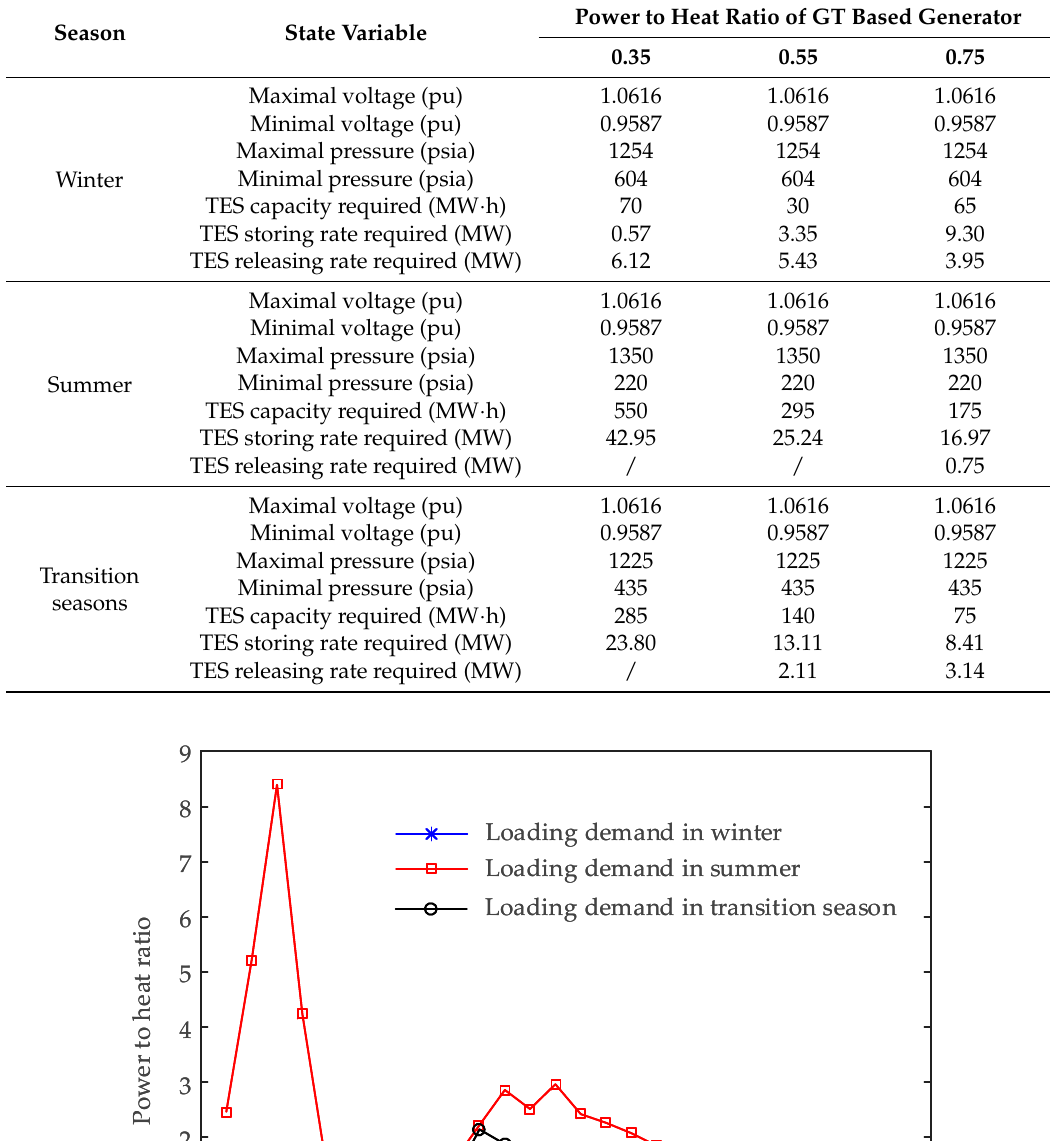
Table 2. System states under different power to heat ratio based CHP generations (FEL mode).